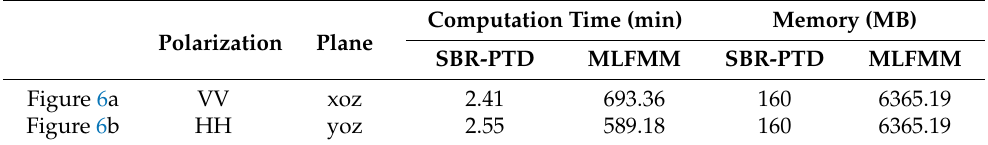
Table 1. Computation cost comparison between accelerated SBR-PTD and MLFMM in Figure 6.